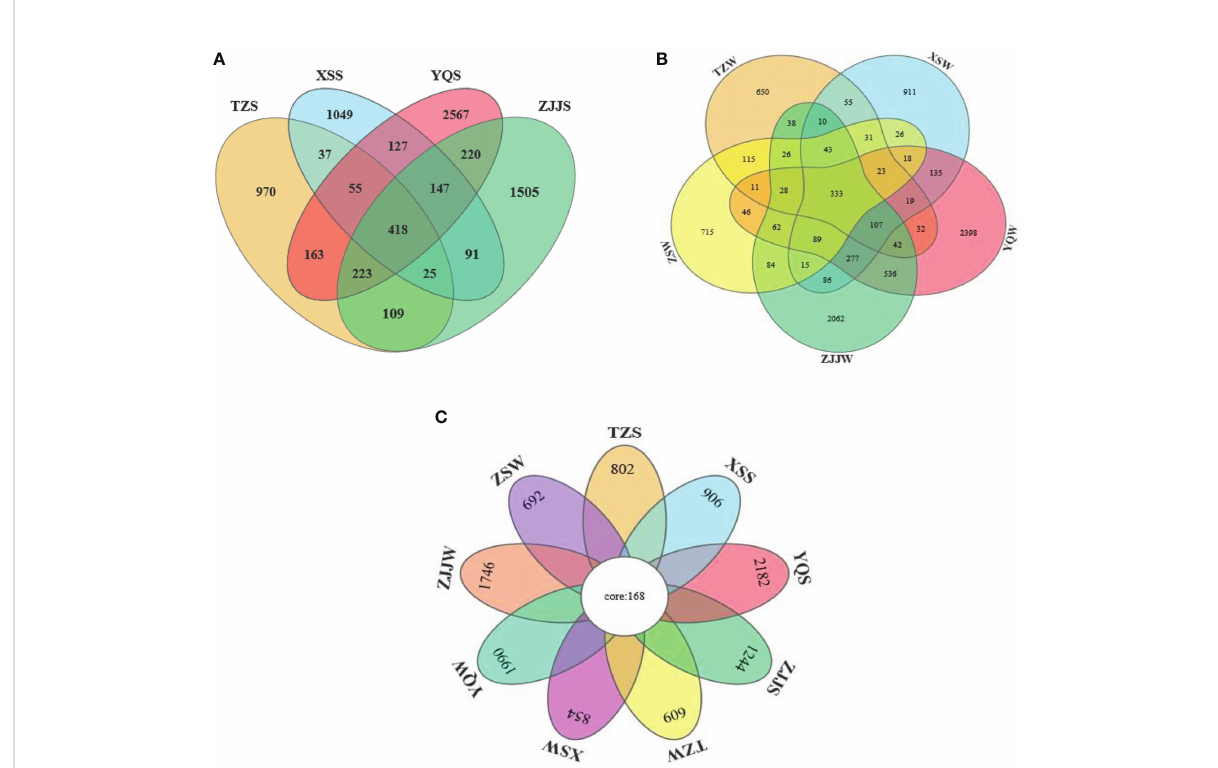
FIGURE 2 Venn diagrams of the OTUs distribution denoting the unique and core OTUs (A) in the sediment groups, (B) in the seawater groups and (C) in all nine